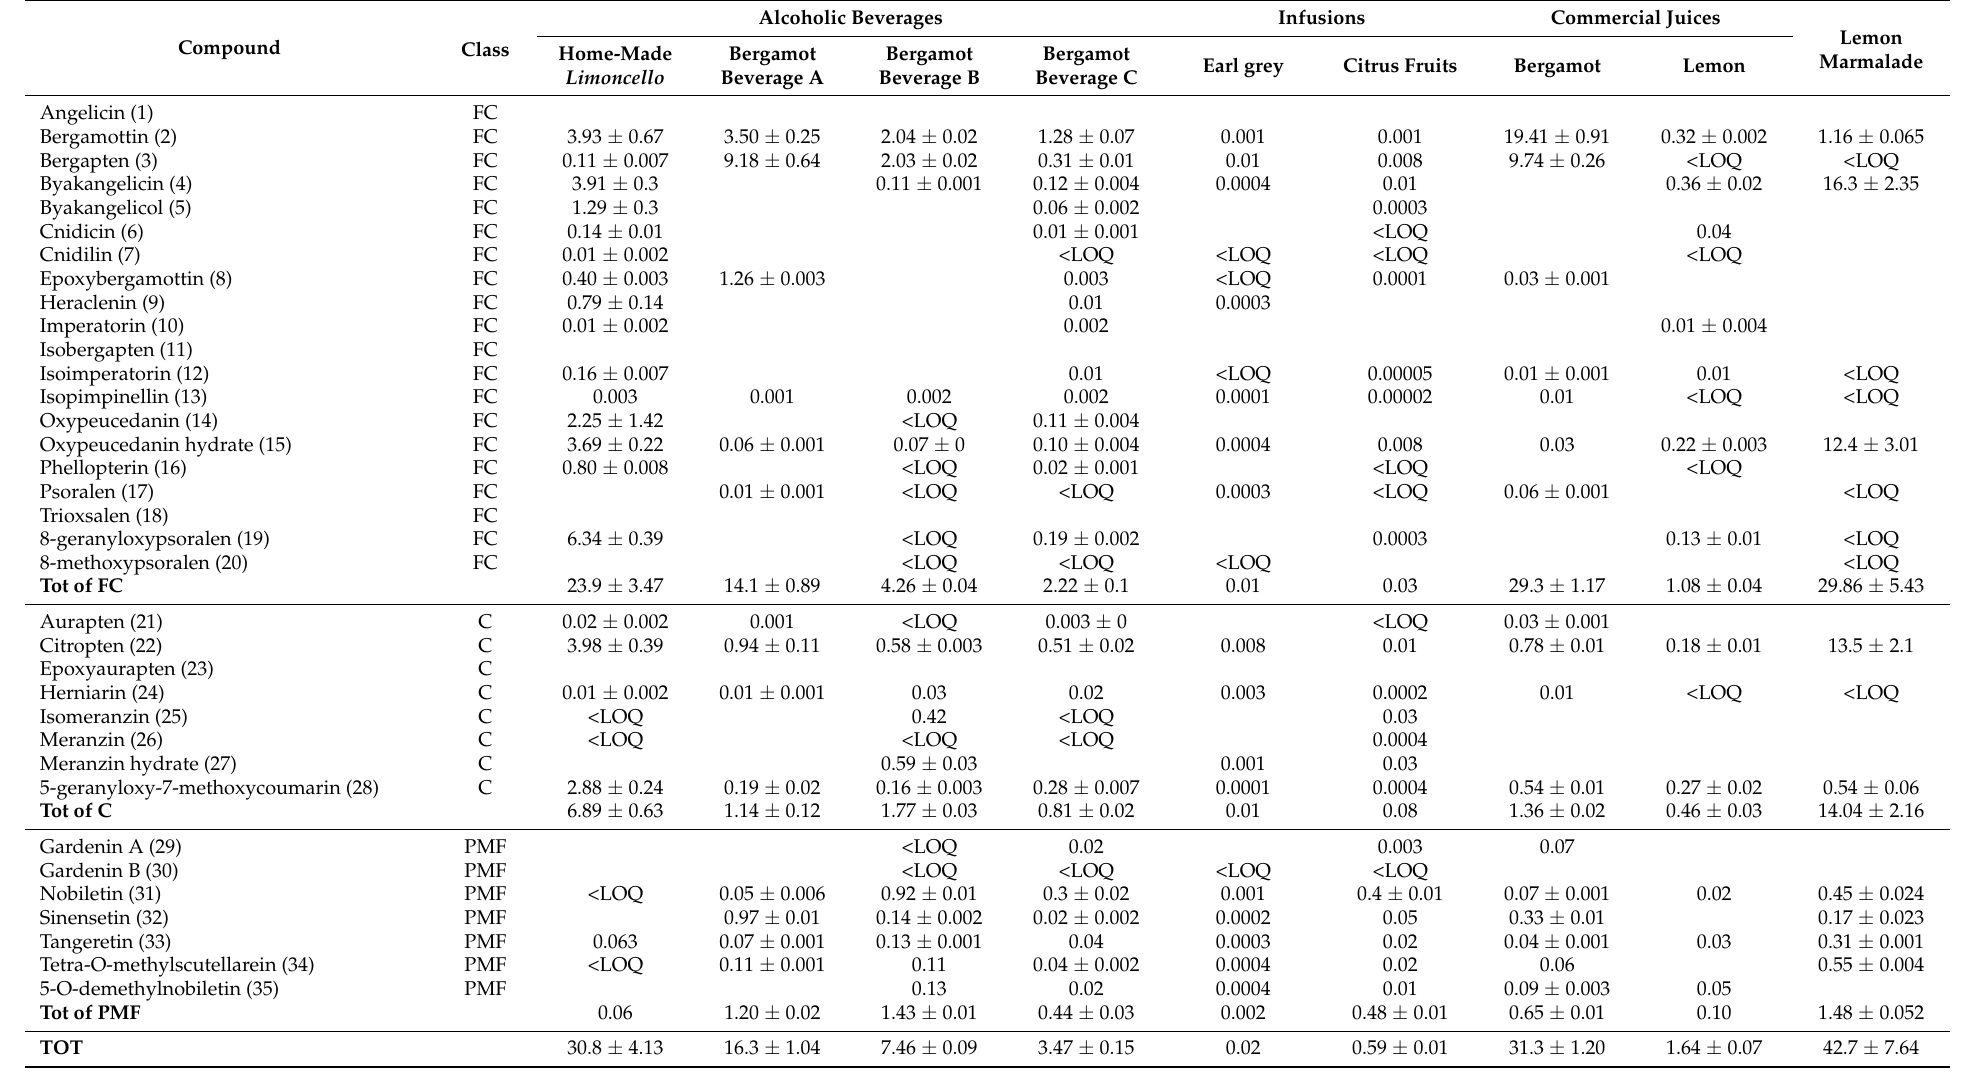
Table 2. Amount of OHCs (mg/L), with the corresponding standard deviation, in the samples analysed. Standard deviation less than 0.001 was not reported. LOQ, limit of